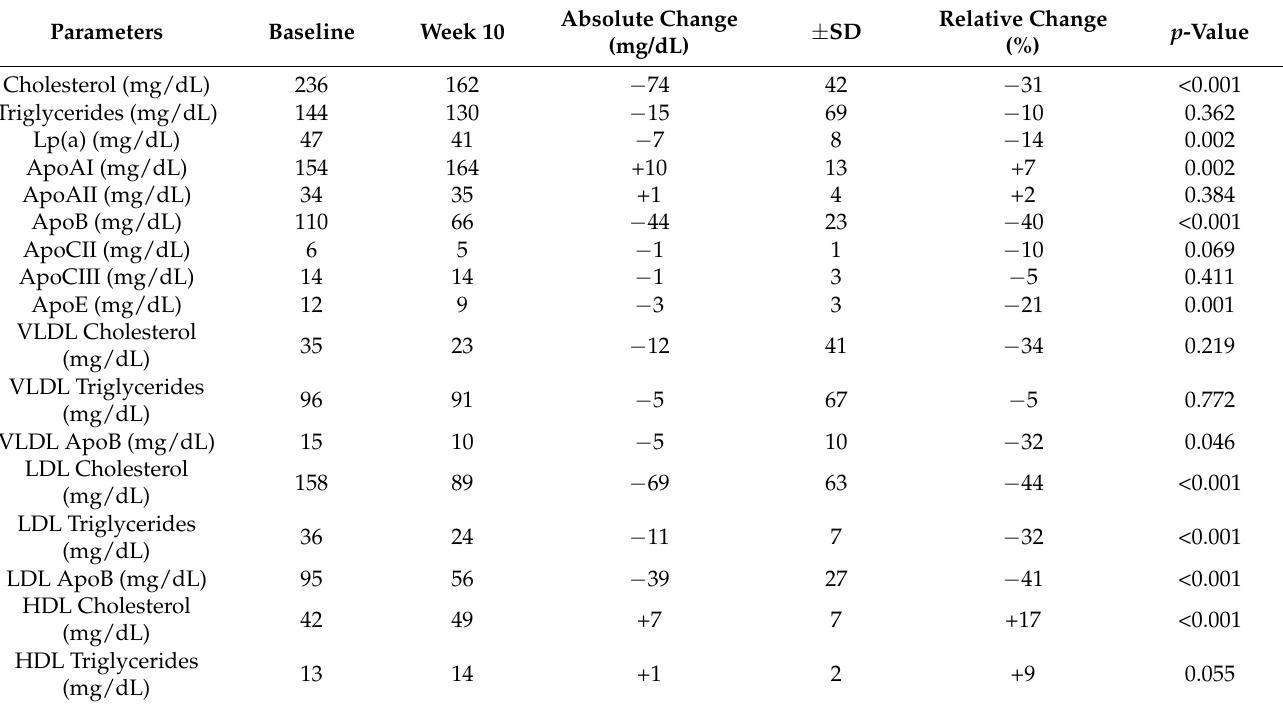
Table 2. Effects of alirocumab on lipids, lipoprotein particle subfractions, and lipoproteins.